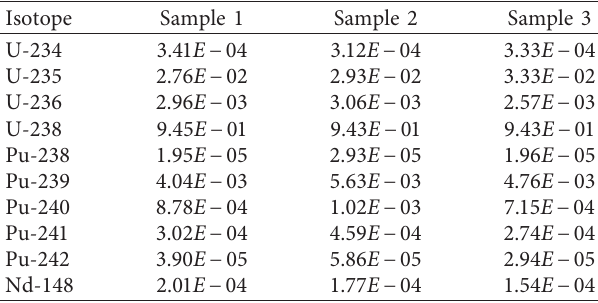
Table 4: Experimental data used for validation for the 2F2D1/F6